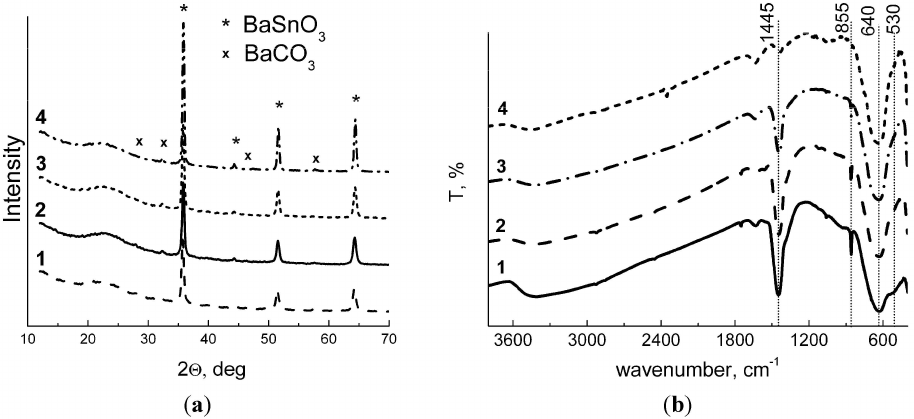
Figure 2. XRD patterns ( a ) and FTIR spectra ( b ) of BaSnO